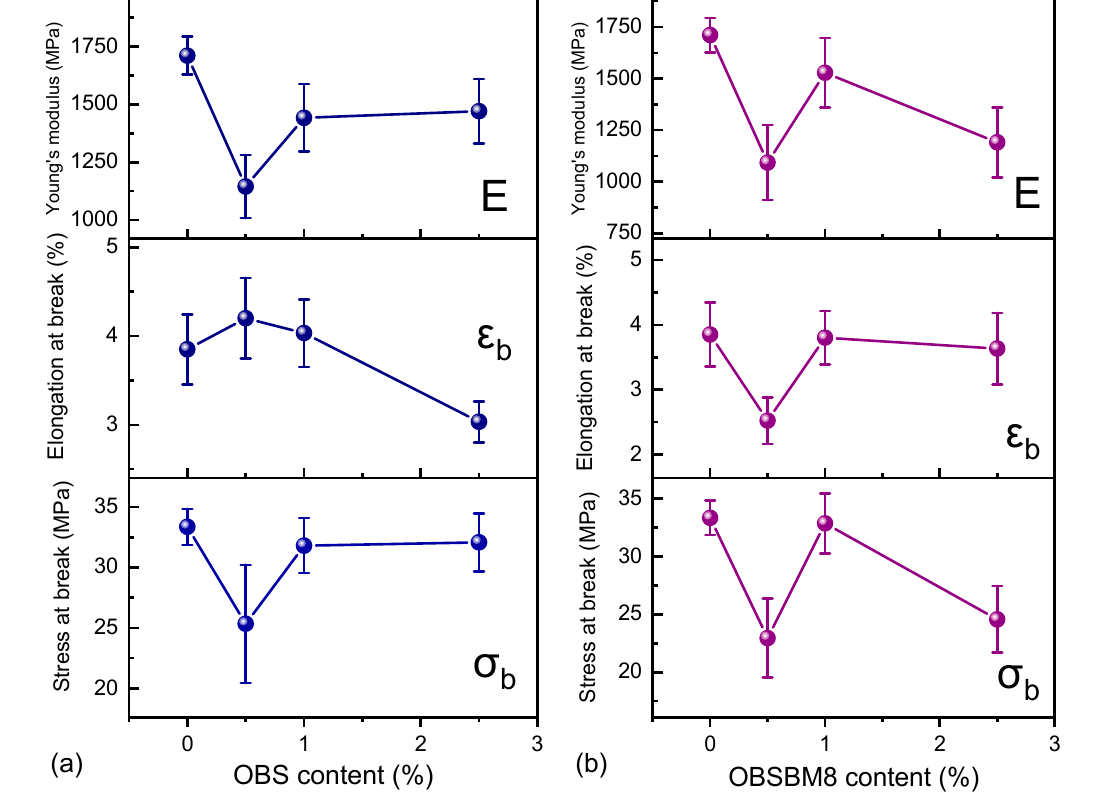
Figure 9. Effect of ( a ) OBS lignin and ( b ) OBSBM8 lignin on the tensile characteristics of PLA. The lines are drawn to guide the eye.